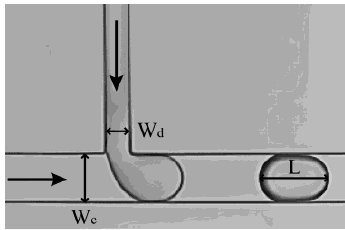
: 50 μm; W : 100 d c